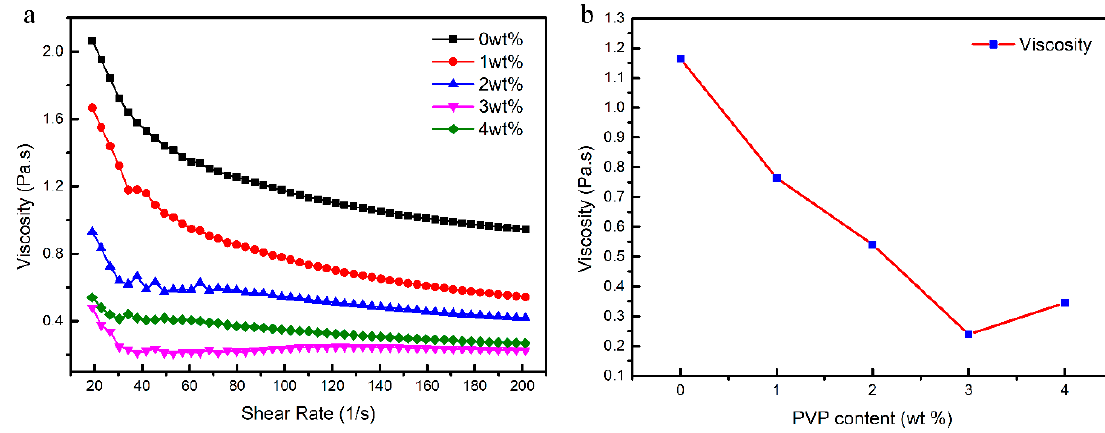
Figure 3. Effect of PVP content on the viscosity of 50 vol % slurries at ( a ) different shear rates and ( b ) 100 s − 1 shear rate.